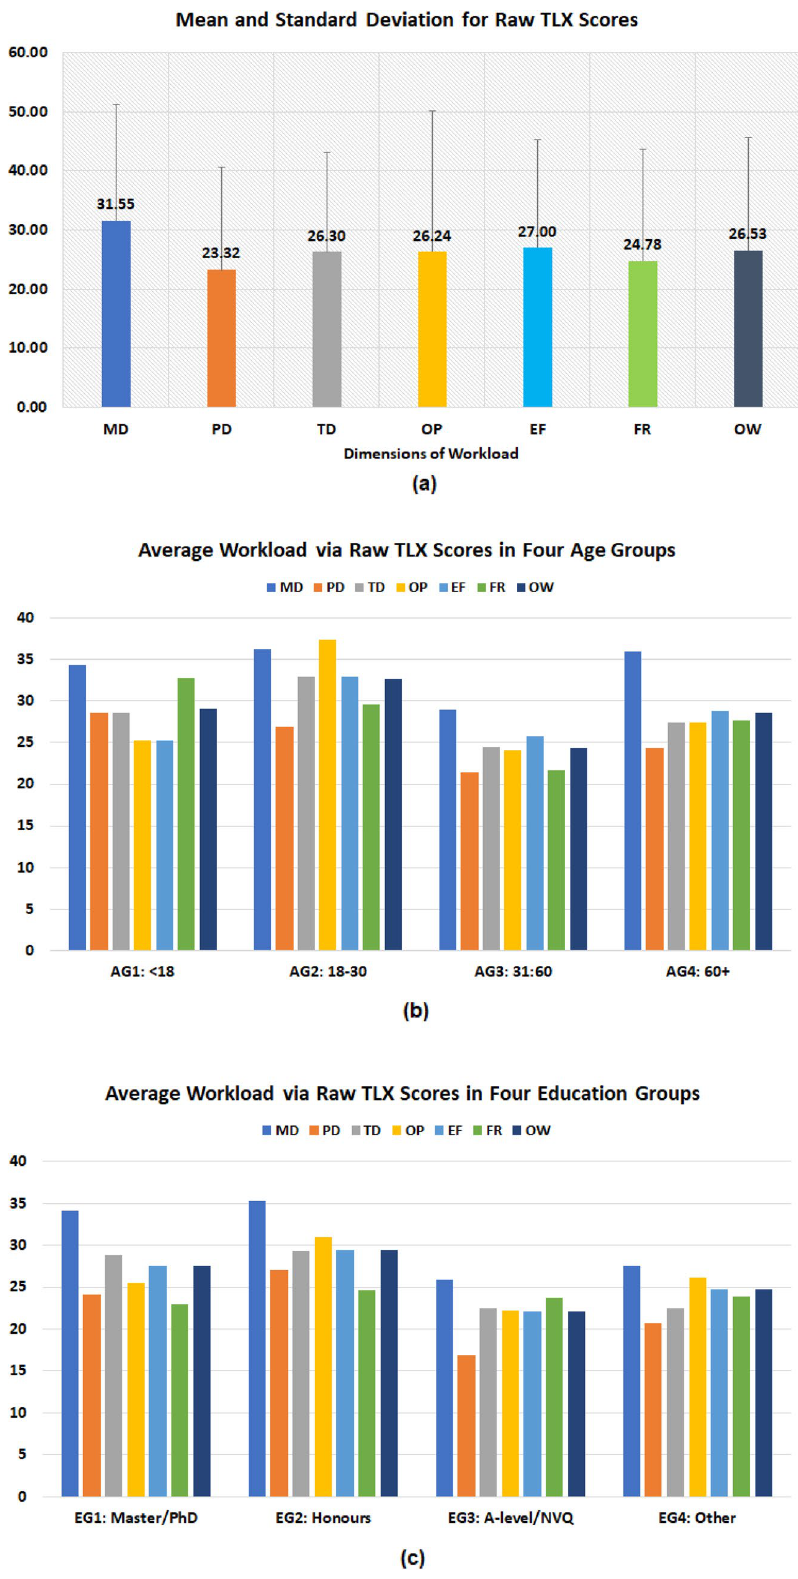
Figure 9. Results of TLX and six subscales: ( a ) mean and standard deviation based on all participants (n = 264); ( b ) mean based on participants from four age groups (AGs); ( c ) mean based on participants from four education groups